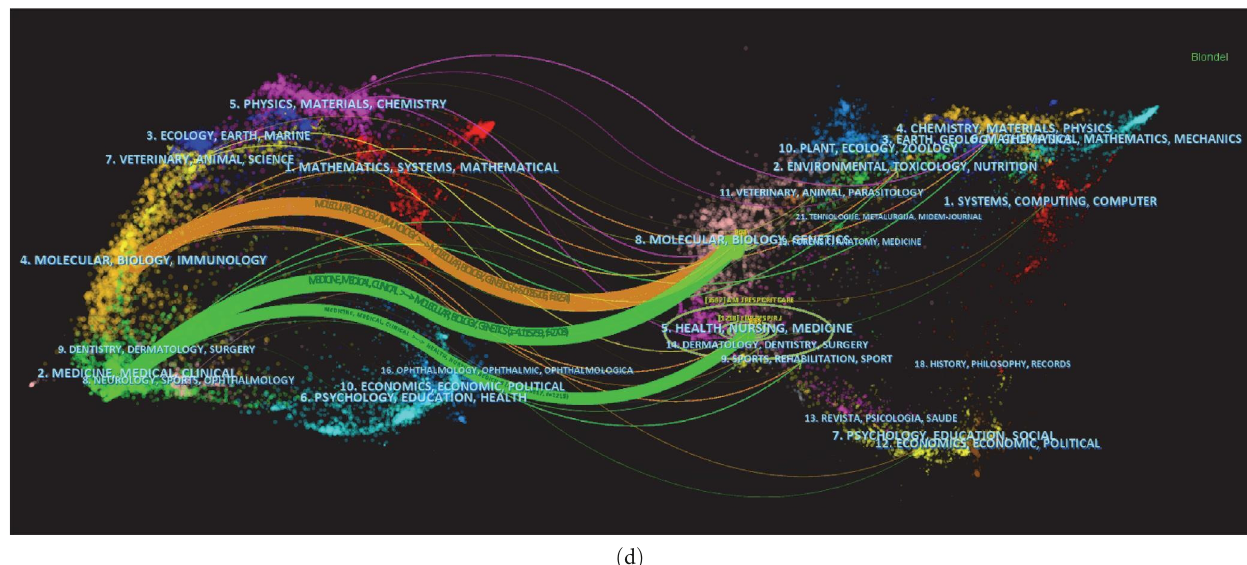
F IGURE 5: Contributions of different journals in the fi eld of IPF and immune response. (a) The top 20 journals ranked by the number of publications. The X -axis represents the percentage of the number of publications by the institution to the total. (b) Map of the citation network of the top 20 journals with at least eight publications in IPF and immune response. The circle size represents the number of publications included. The lines between circles represent the cooperation weight. (c) Journals were colored based on the average citation time. Blue color represents in the early years, and yellow color represents more recently. (d) The dual-map overlay of journals related to IPF and immune response. The citing journals are on the left, and the cited journals are on the right. The color line between them indicates the cited